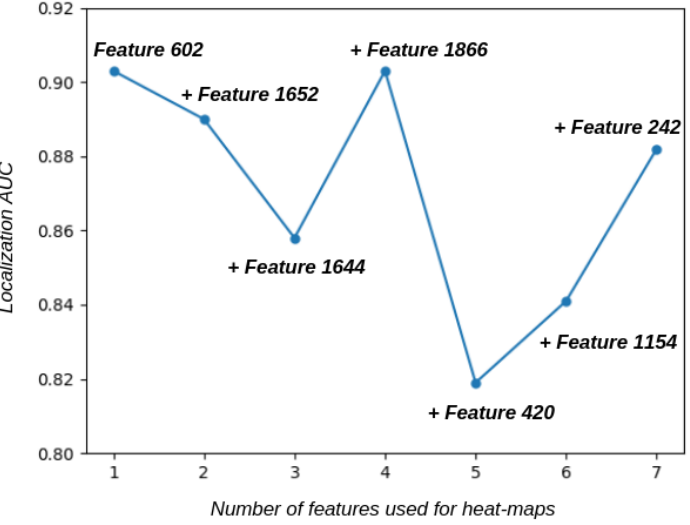
Figure 9. Impact of the number of selected features on localization AUC (between 0.80 and 0.92) for small numbers of features.